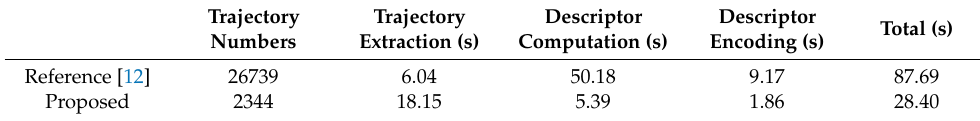
Table 3. Comparison of the average time consumption per video for the